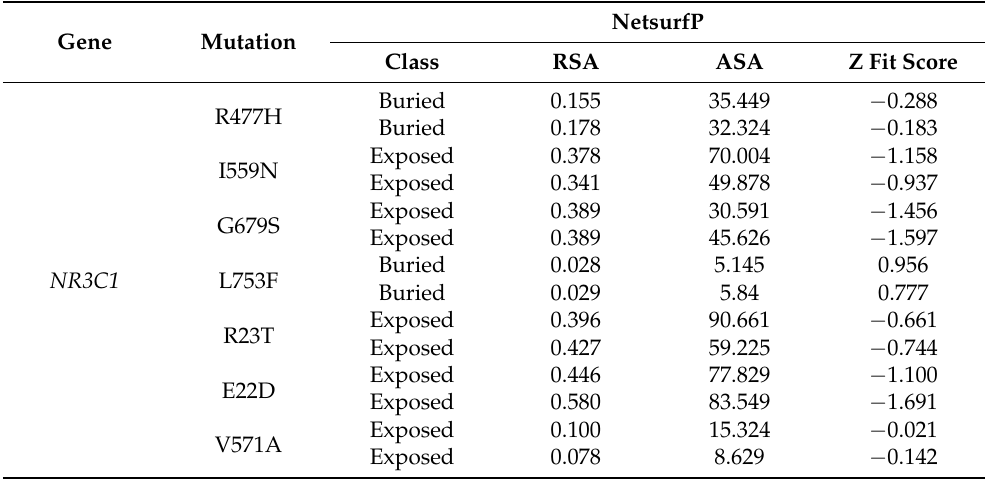
Table 6. Prediction of relative surface accessibility of NR3C1 through NetsurfP.